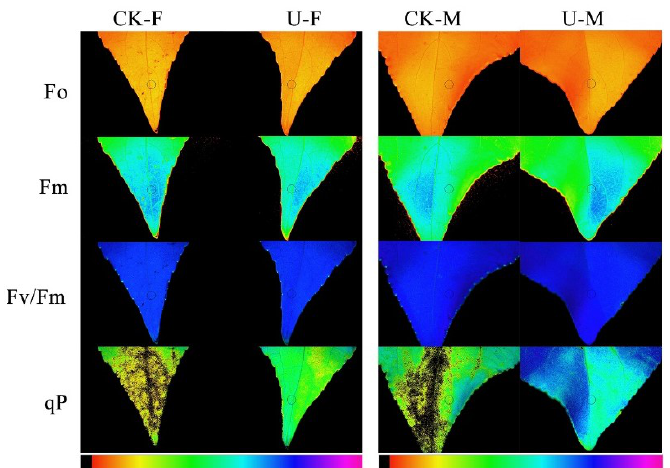
Figure 4. Chlorophyll fluorescence images of Fo, Fm, and Fv/Fm in a dark-adapted leaf and NPQ, Y(II), and qP at steady-state with actinic illumination of 400 µ mol · photons · m − 2 · s − 1 measured at the end of the experiment in leaves of different treatments. The false color code depicted at the bottom of each image ranges from 0.000 (black) to 1.000 (pink).